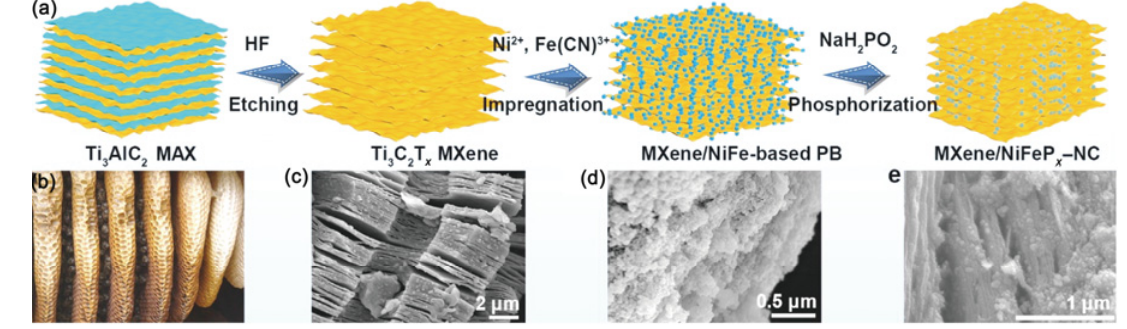
Fig. 1 (a) Schematic illustration of synthesis of MXene/NiFeP x –NC electrocatalyst. (b) Scheme of honeycomb. SEM images of (c) multi-layered Ti 3 C 2 T x MXene, (d) MXene/NiFe-based PB, and (e) honeycomb-like MXene/NiFeP x –NC